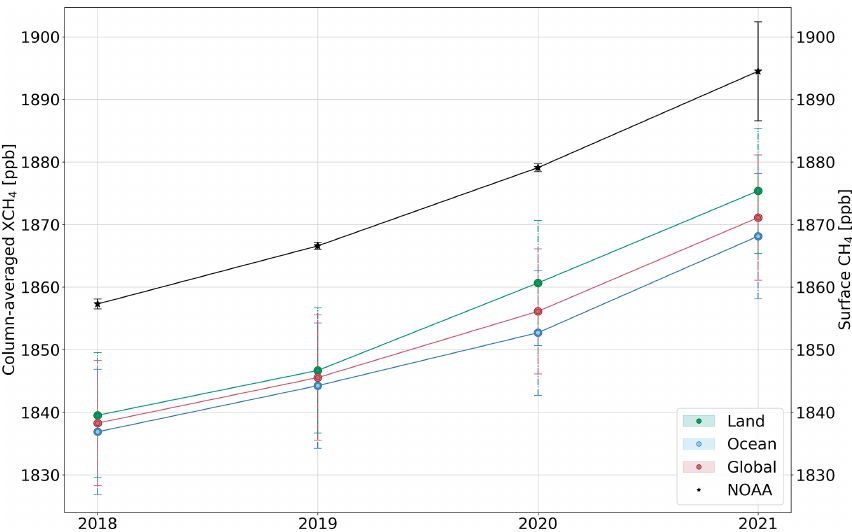
Figure 2. Time series of annual mean XCH 4 distribution calculated from TROPOMI measurements over land, over ocean and globally (land and ocean) and globally averaged surface CH 4 determined from NOAA marine surface